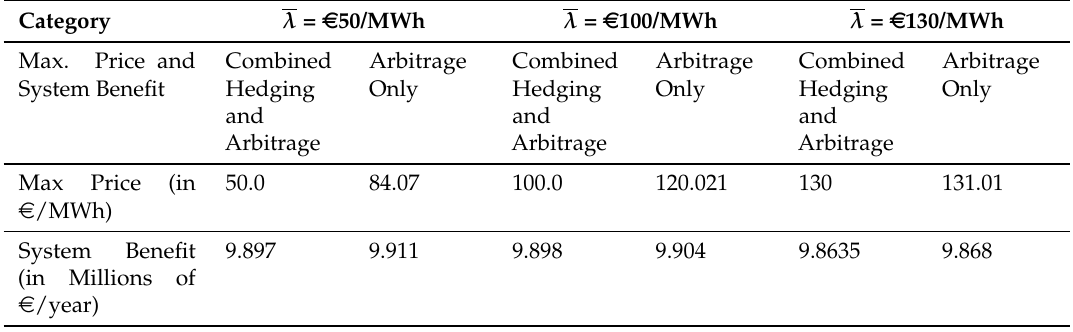
Table 1. Comparative analysis of maximum price and system benefit (negative of the objective function in Equation (11)), between combined hedging and arbitrage and arbitrage only. Category λ = e 50/MWh λ = e 100/MWh λ = e 130/MWh